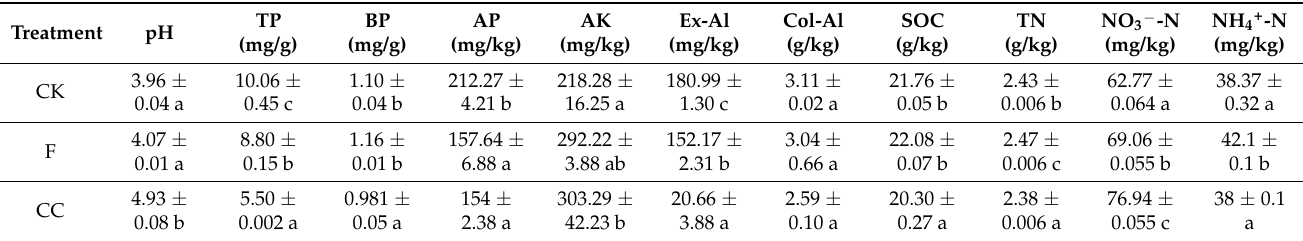
Table 1. Physical and chemical properties of the soil from the control, flooding and calcium cyanamide treatments in tea